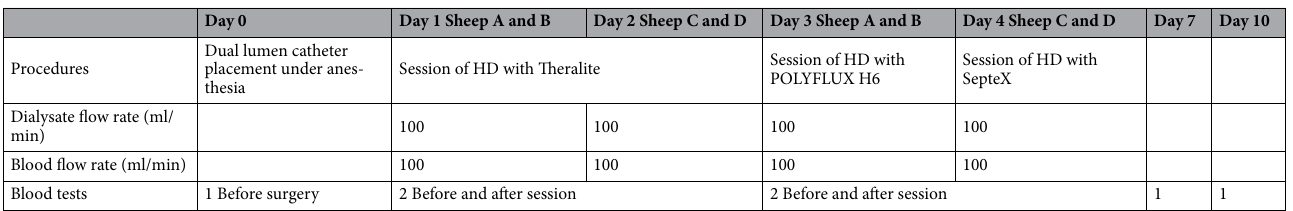
Table 1. Description of in vivo experiments on healthy sheep with different dialyzers